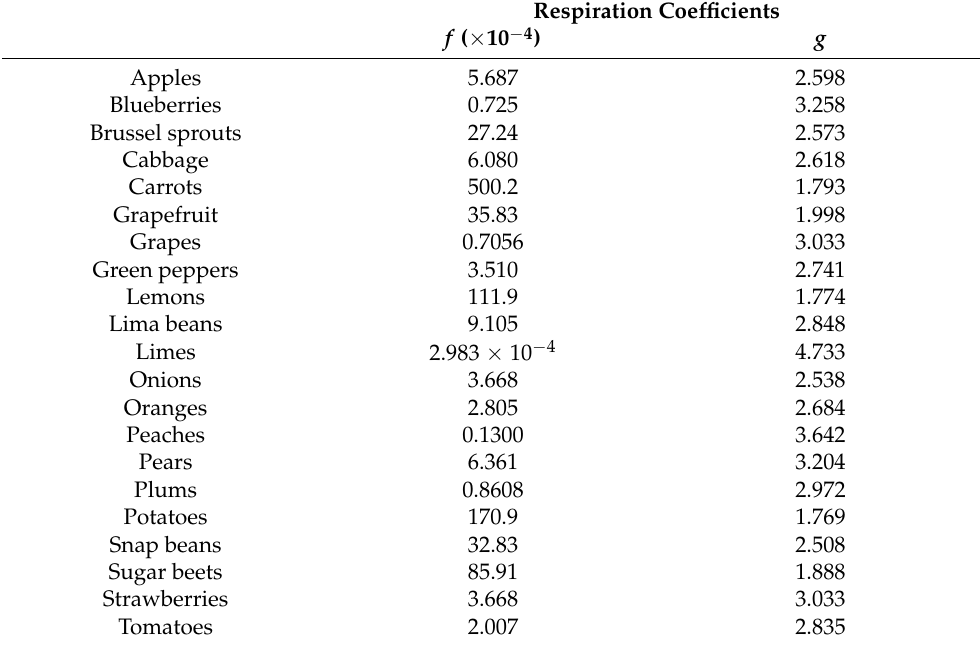
Table 1. Respiration coefficients ( f and g ) of different horticultural products obtained via a least- squares fit to published data [2,4].